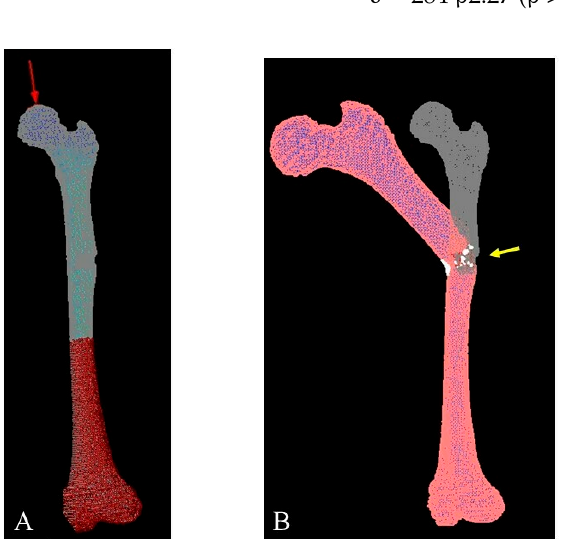
Figure 6. A three-dimensional finite element (FE) femur model was developed from computed tomography images. ( A ) The direction of compression was parallel to the mechanical axis. ( B ) FE analysis using the FE model was ended when fractured.